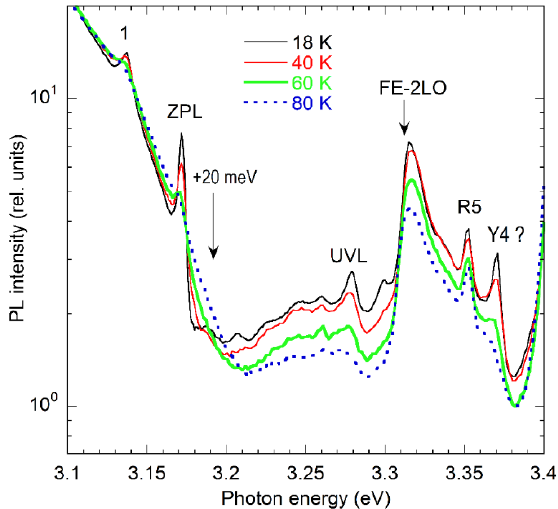
Figure 3. Transformation of PL spectrum with temperature ( P exc = 100 W/cm 2 ). The ZPL of the BL C band at 3.172 eV decreases, and a shoulder indicated with the arrow “+20 meV” increases with tem- perature.